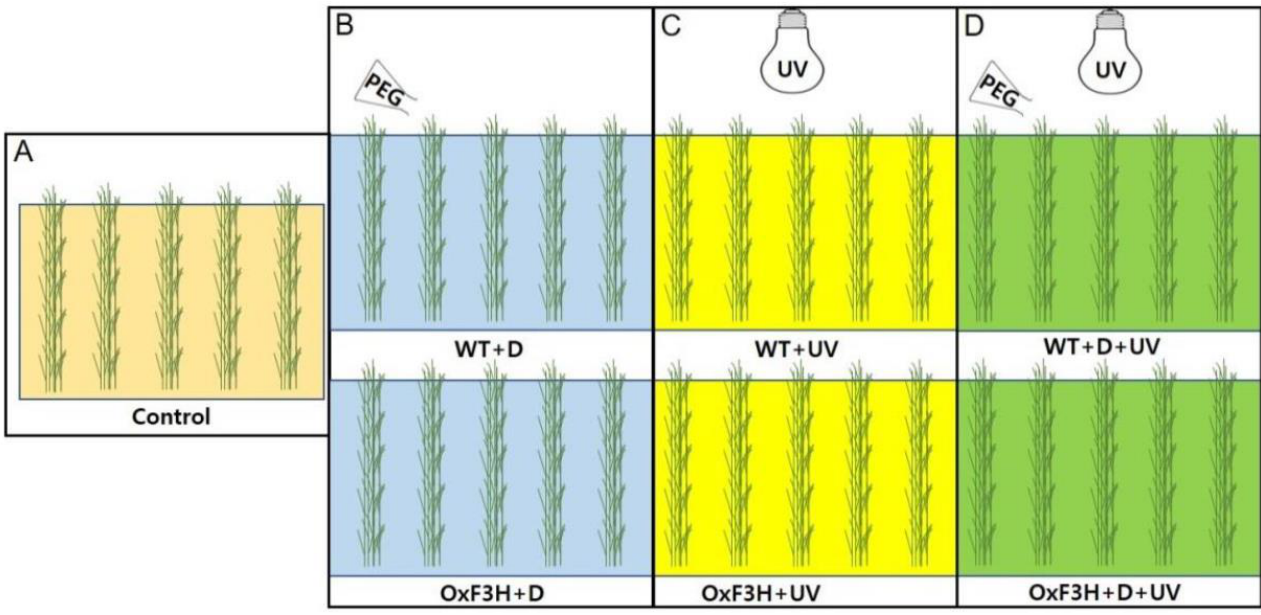
Figure 1. Experimental design of the growth chamber experiment, indicating the seven experi- mental boxes and application of drought and UV-B radiation stress. Box ( A ) shows control plants.